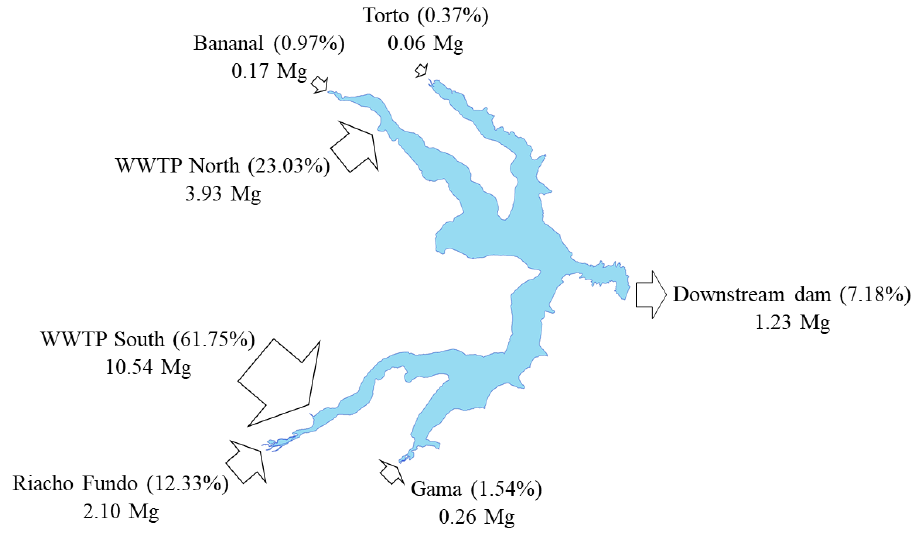
Figure 8. Annual PO 43 − -P budget for Lake Paranoá.